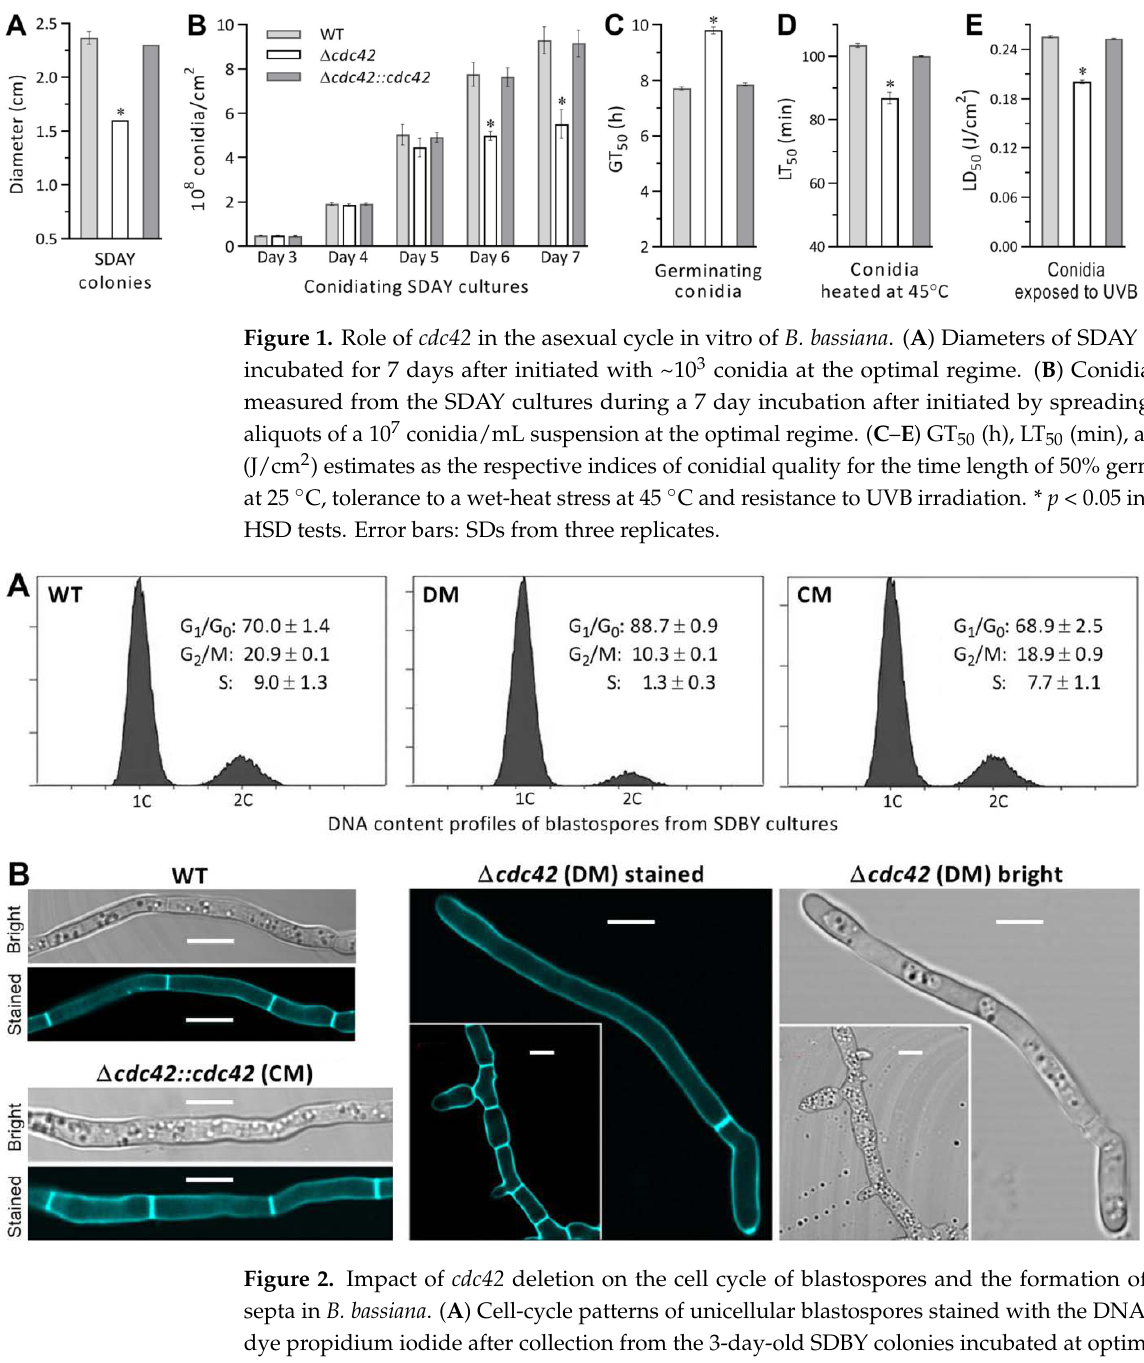
Figure 1. Role of cdc42 in the asexual cycle in vitro of B. bassiana . ( A ) Diameters of SDAY colonies incubated for 7 days after initiated with ~10 3 conidia at the optimal regime. ( B ) Conidial yields meas- ured from the SDAY cultures during a 7 day incubation after initiated by spreading 100 μL aliquots of a 10 7 conidia/mL suspension at the optimal regime. ( C – E ) GT 50 (h), LT 50 (min), and LD 50 (J/cm 2 ) estimates as the respective indices of conidial quality for the time length of 50% germination at 25 °C, tolerance to a wet-heat stress at 45 °C and resistance to UVB irradiation. * p < 0.05 in Tukey’s HSD tests. Error bars: SDs from three replicates.